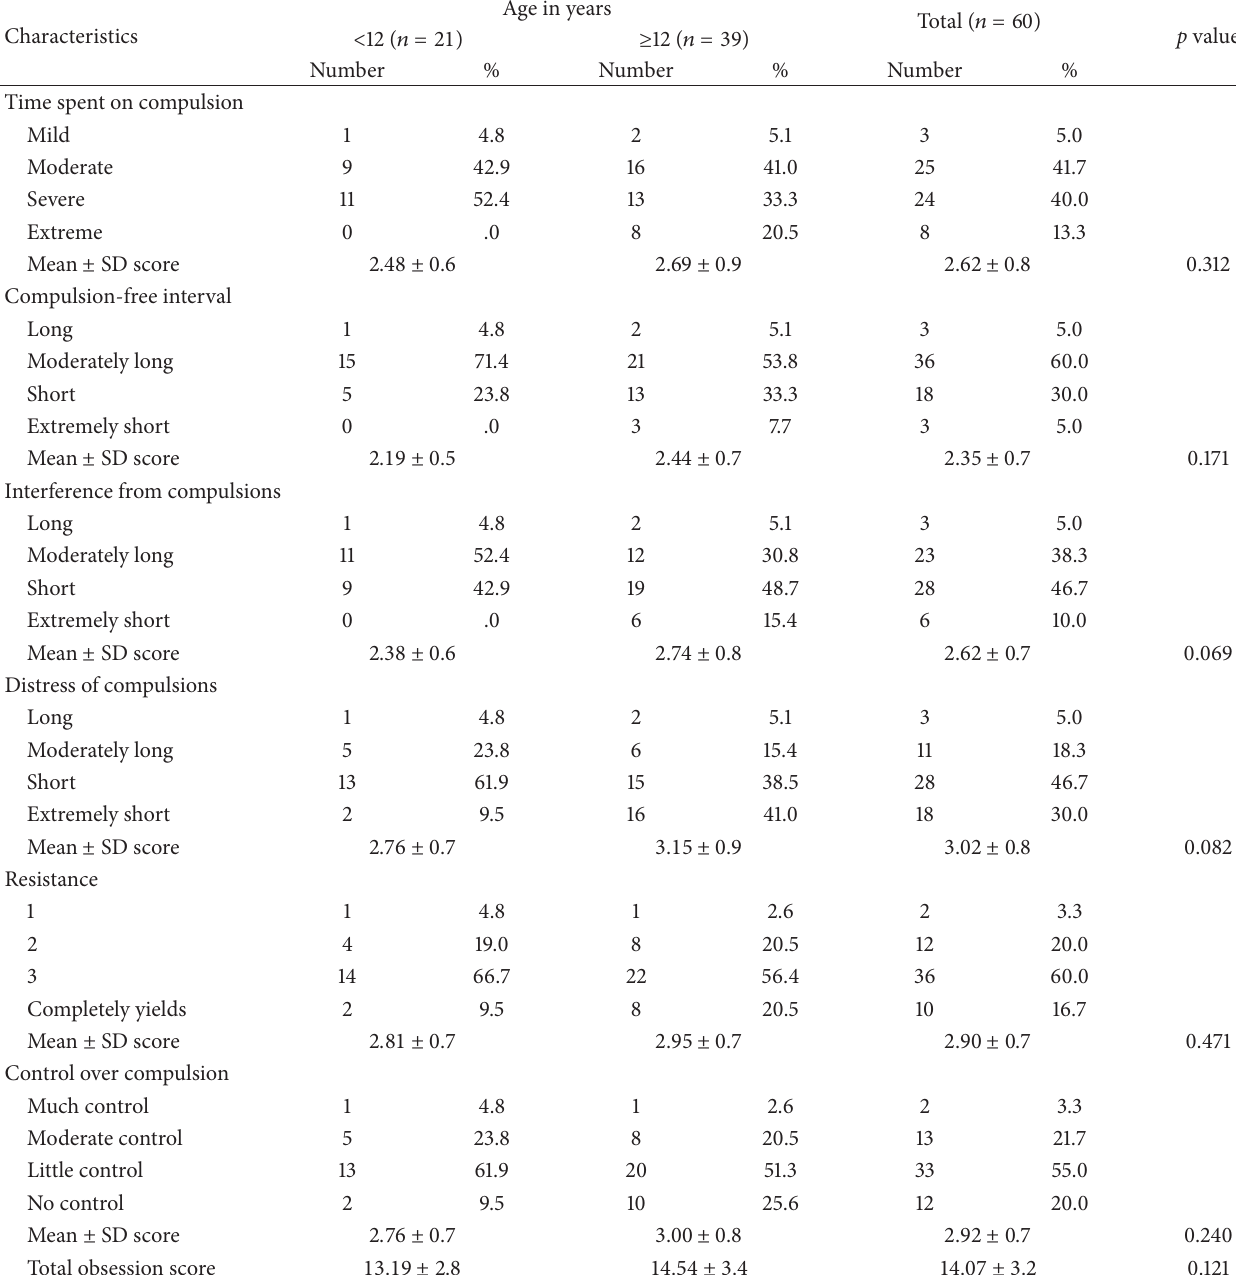
Table 3: Characteristics feature of compulsion according to Children’s Yale-Brown Compulsive